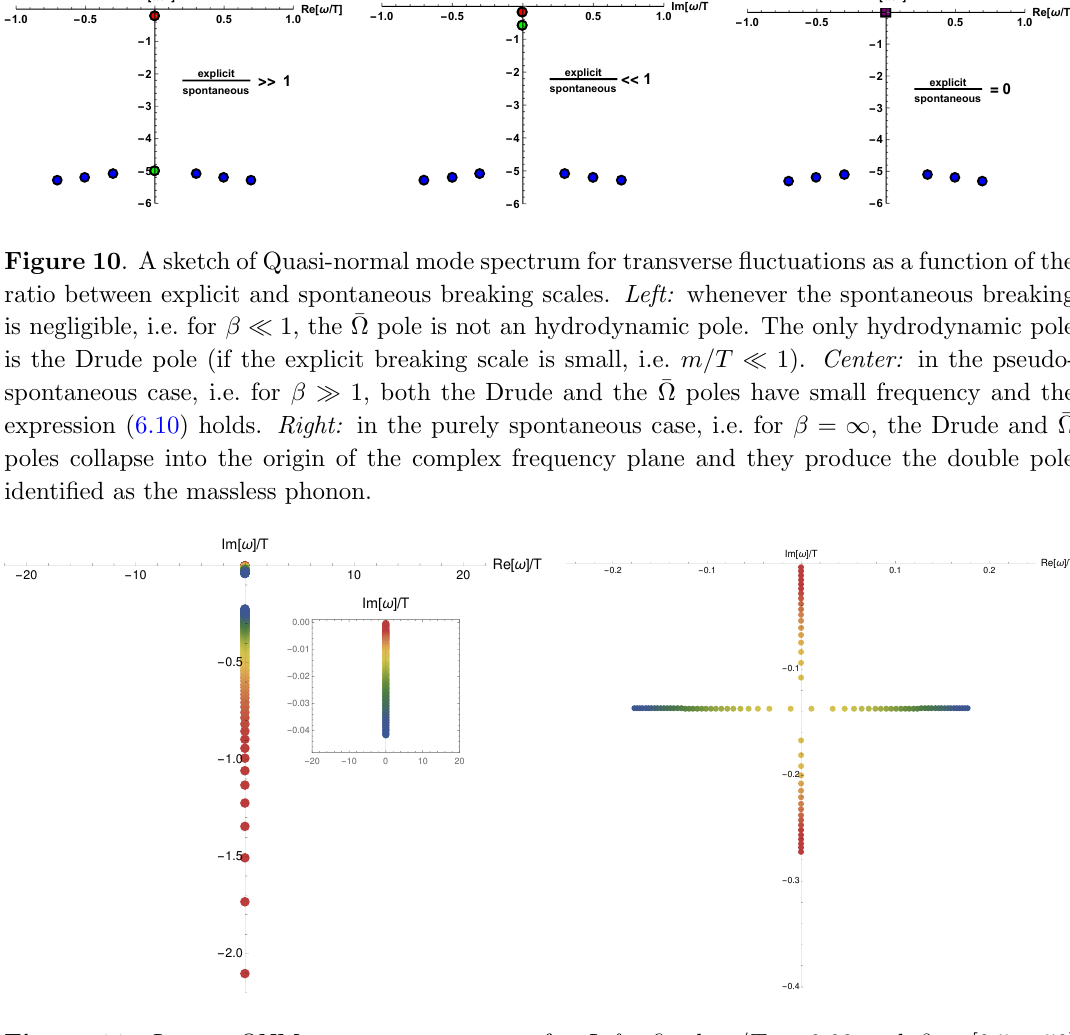
Figure 11 . Lowest QNMs at zero momentum for Left: (cid:12)xed m=T = 0 : 03 and (cid:12) 2 [0 : 5 (cid:0) 50] (red-blue). Right: (cid:12)xed (cid:12) = 50 and increasing m=T 2 [0 : 01 ; 0 :